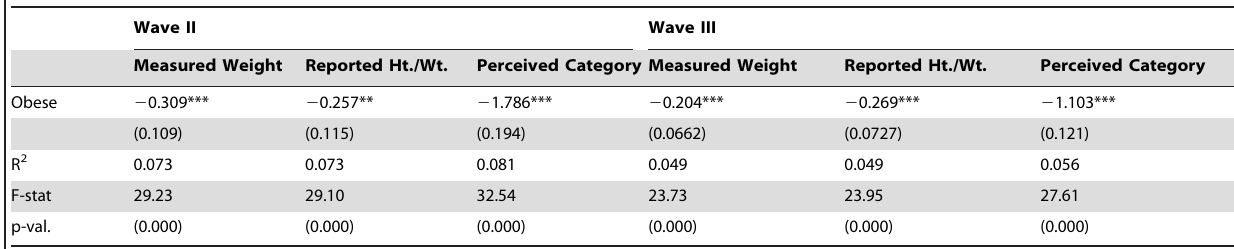
Table 3. The Estimated Effect of Obesity on Mental Health.